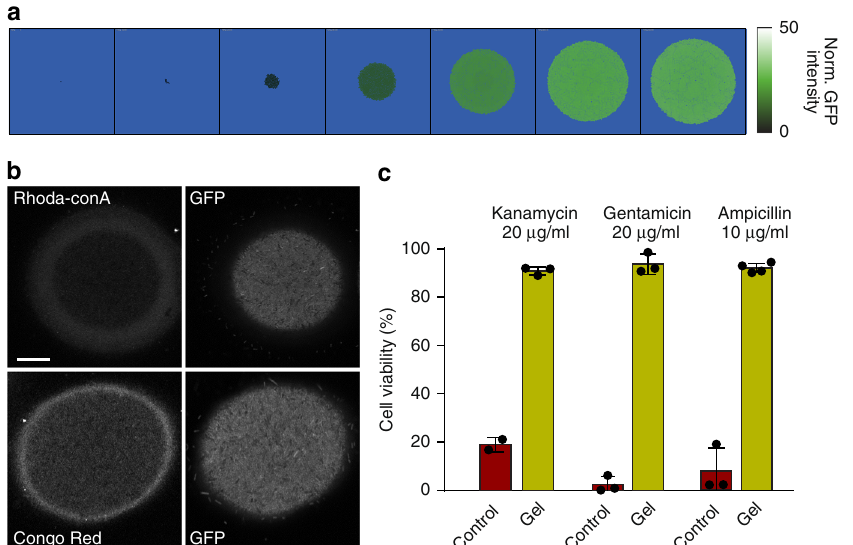
Fig. 4 Bio fi lm growth in environment with mechanical resistance. a Filmstrip of a simulated colony growing in hydrogel. The green color scale encodes the level of stress response. b Spatial distributions of stress-reporting GFP and bio fi lm-like cell-surface structures in E. coli (JM105) colonies grown in 1% PuraMatrix hydrogel. CLSM was used to visualize both the rhodamine-labeled concanavalin A-stained EPS D -( + )-glucose and mannose groups and the Congo Red-stained curli after ~6 h of growth. Scale bar, 20 µ m. c Viability comparison between planktonic and 6 h hydrogel cultures after exposure to 20 μ g/mL of kanamycin (JM105) ( n = 2 for control, n = 3 for gel), 20 μ g/mL of gentamicin (CFT073) ( n = 3), and 10 μ g/mL of ampicillin (CFT073) ( n = 3 for control, n = 4 for gel). Error bars are